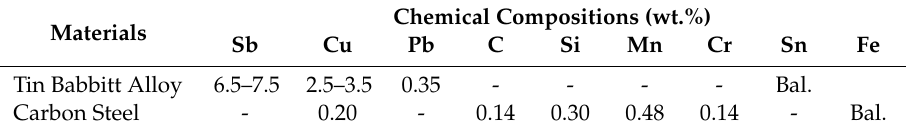
Table 1. Chemical compositions of tin-based Babbitt alloy and carbon steel substrate.